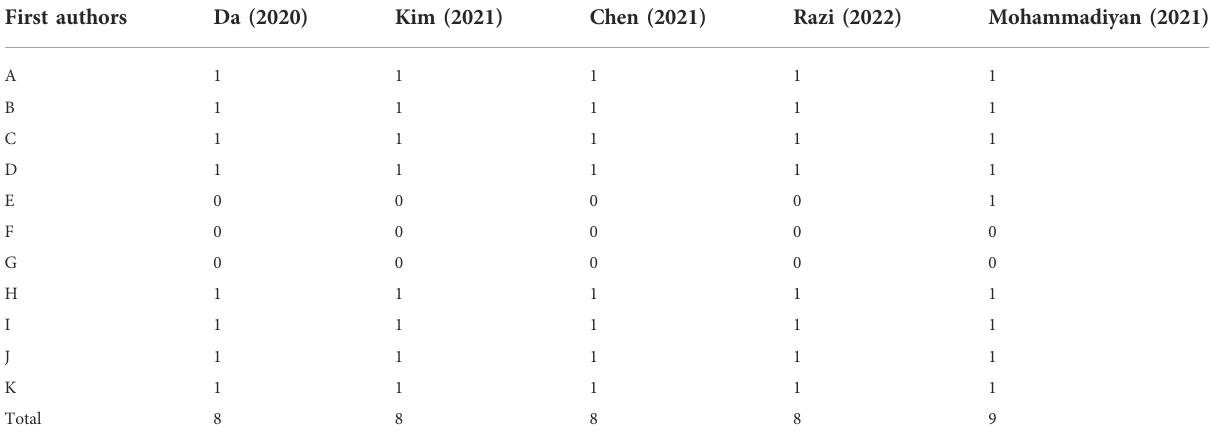
Abbreviations: PEDro, scale items (each satis fi ed item except the fi rst item contributes one point to the total PEDro, score): A, eligibility criteria; B,randomization; C, allocation concealment;D,similaratbaseline;E,blindedsubjects;F,blindedtherapist;G,blindedassessors;H, < 15%dropouts;I.ITT,analysis;J,between-groupcomparison;K,pointandvariability measures; 1, item positive; 0, item negative or